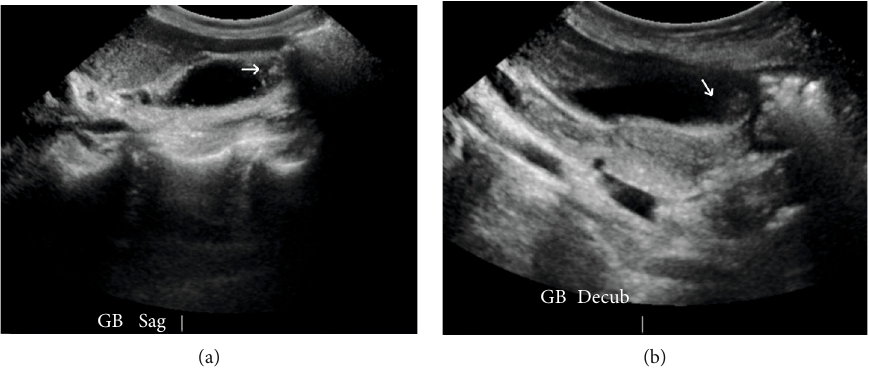
Figure 1: (a) US of the gallbladder, sagittal view revealed cholelithiasis. (b) US of the gallbladder, decubitus view revealed cholelithiasis.